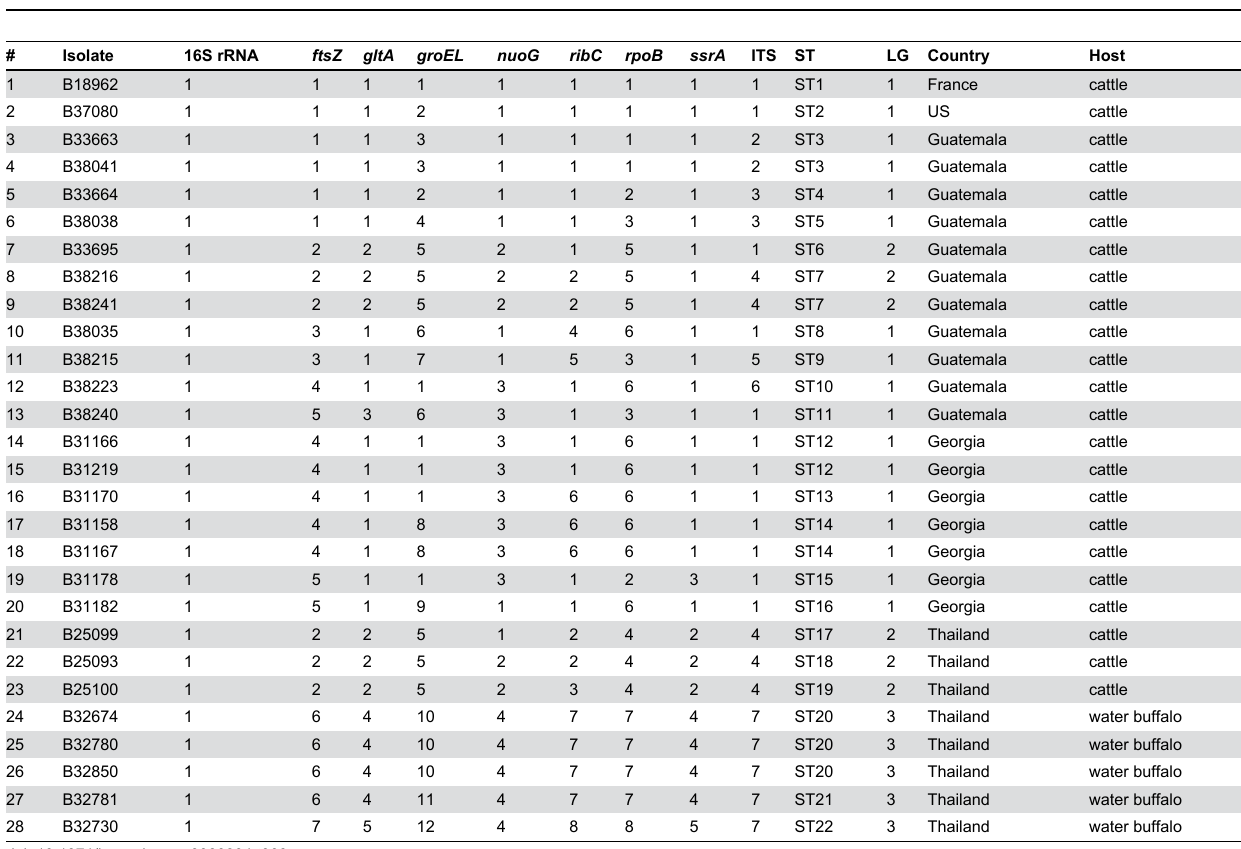
Table 3. Allelic profiles, sequence types (ST), and lineage group (LG) classification for the 29 B. bovis isoaltes from different geographic locations and bovine